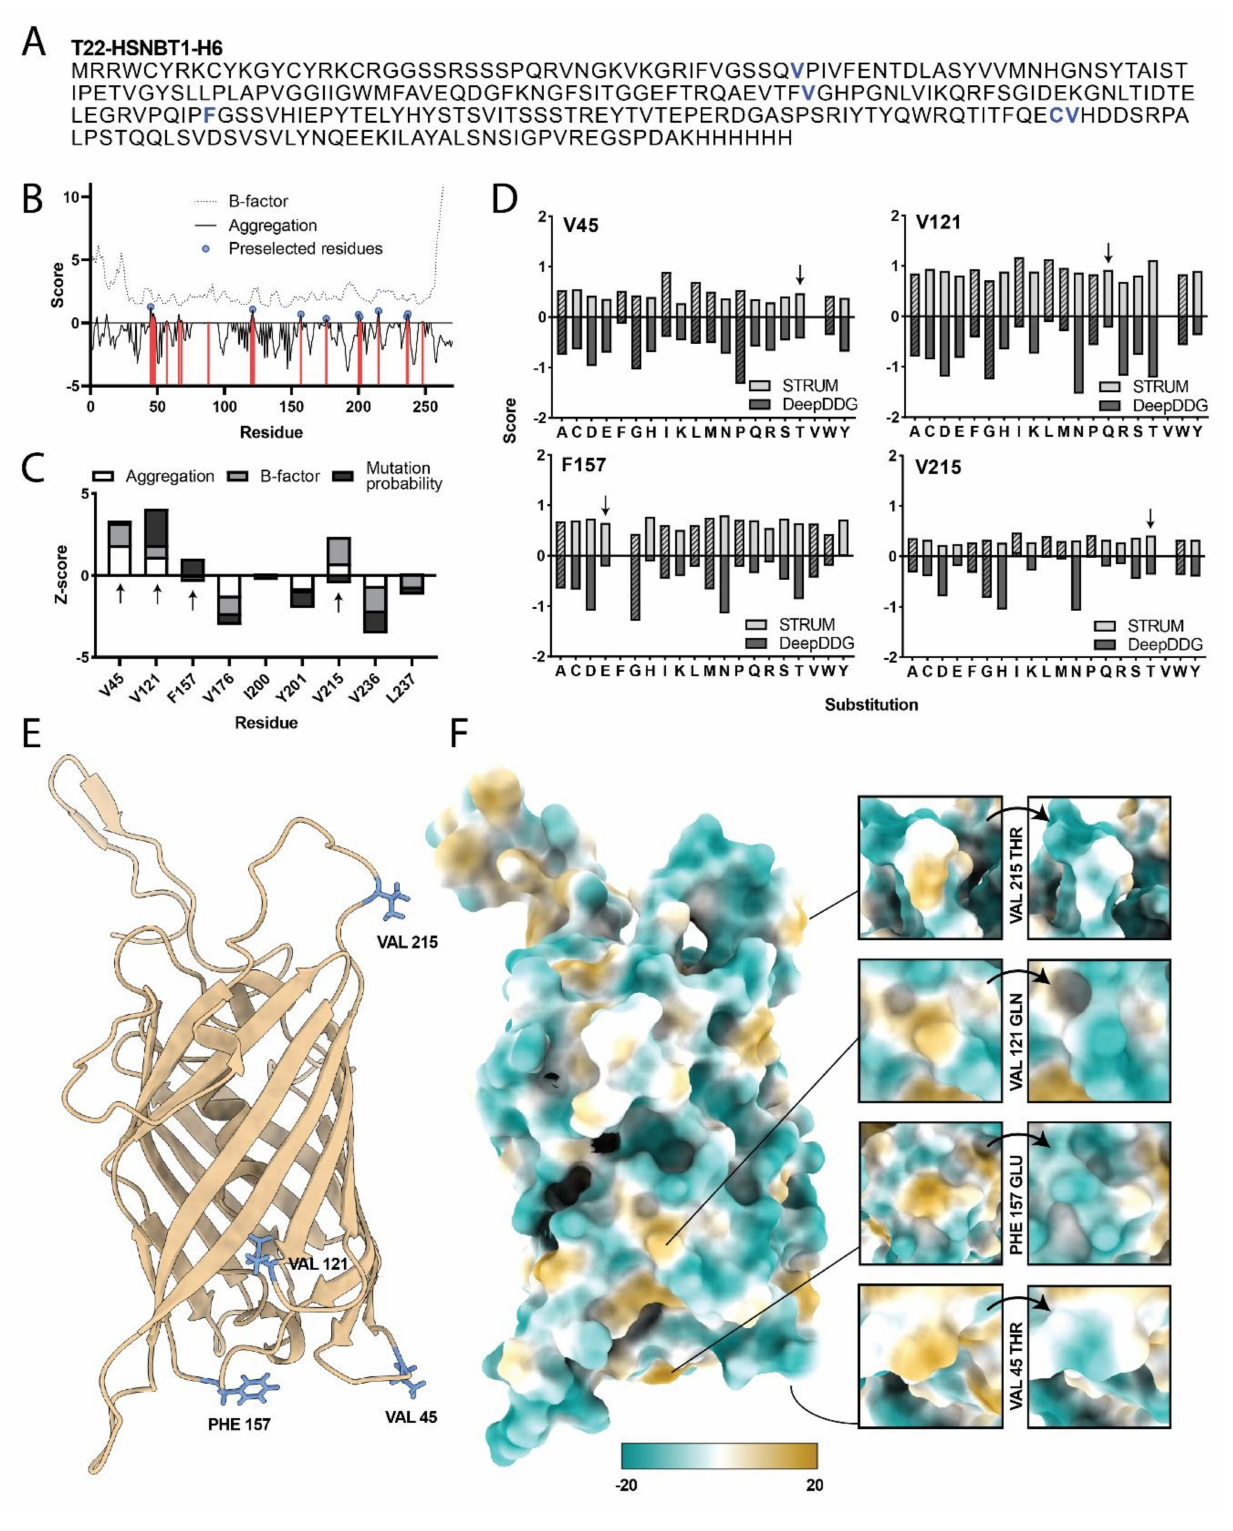
Figure 1. ( A ) Amino acid sequence of the construct T22 − HSNBT1 − H6. Residues mutated at some point are highlighted in bold and blue; numeration starts at Met0. ( B ) Visualization of B-factor (dotted line) and aggregation (continuous line) predictors for each residue in T22-HSNBT1-H6. Positive aggregation values indicate tendency to aggregate and are highlighted in red. Preselected residues are marked with blue dots. ( C ) Stacked aggregation (Aggrescan3D), B-factor (ResQ), and mutation probability (STRUM) prediction scores of the preselected residues. ( D ) Scores of STRUM (light